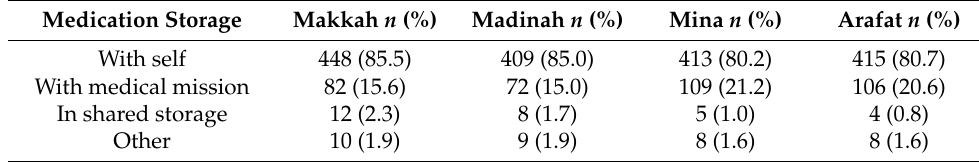
Table 4. Medication storage during Hajj among